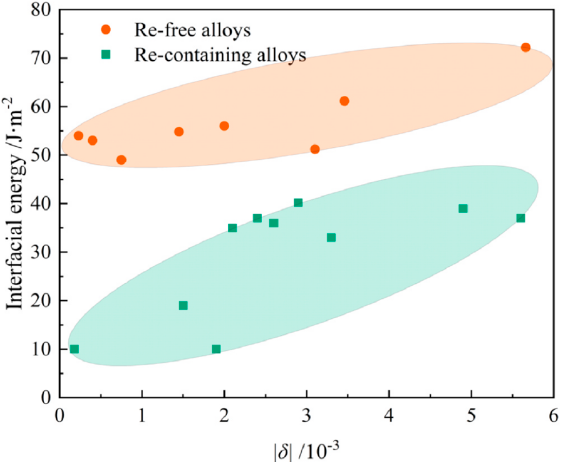
Figure 12. Lattice misfit dependence of interfacial energy in different alloys [57].